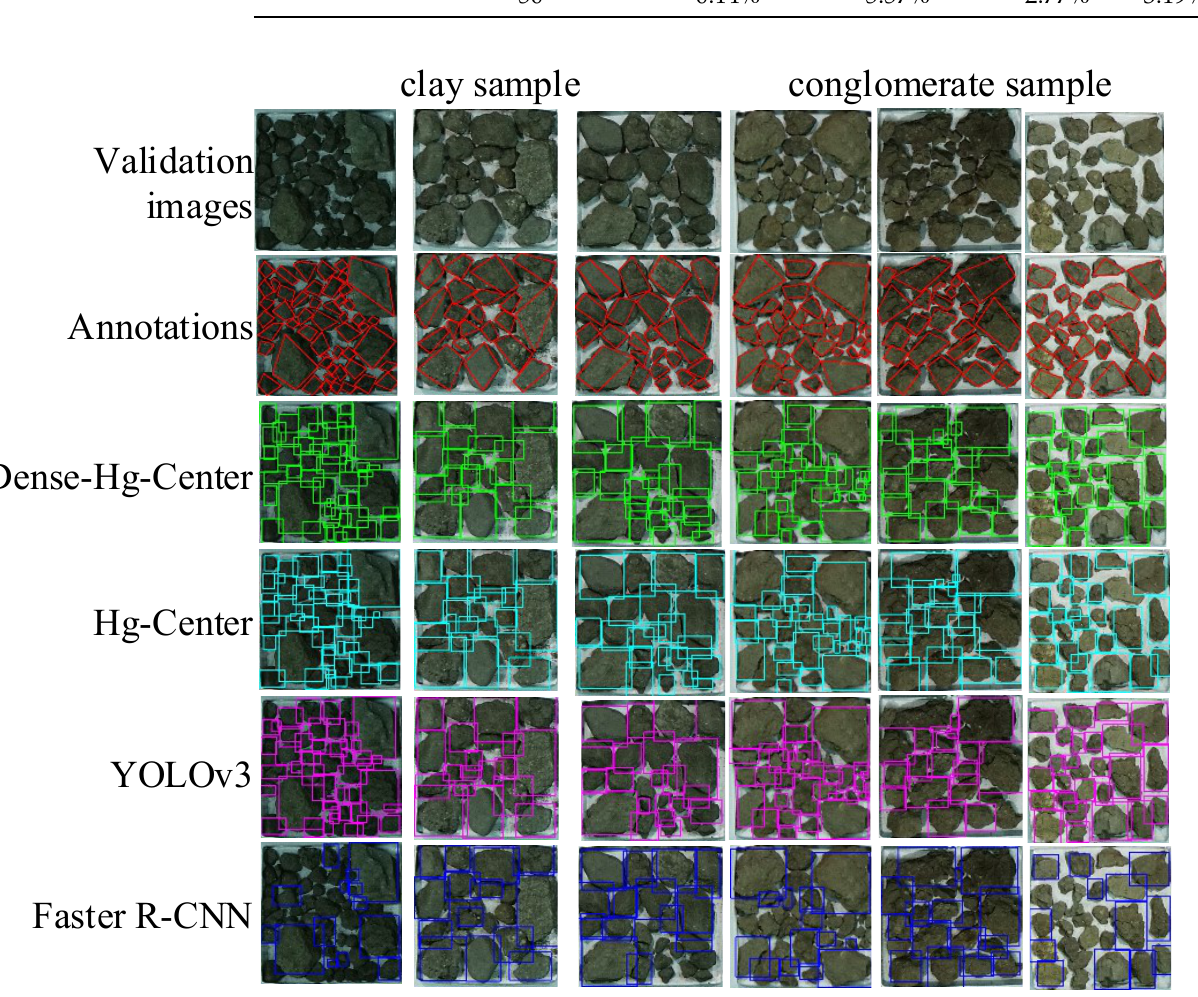
Figure 7. The visualization of our comparison experiments. Table 4 shows the target detection comparison experiments as well as the granularity detection comparison experiments performed on the conglomerate validation set of